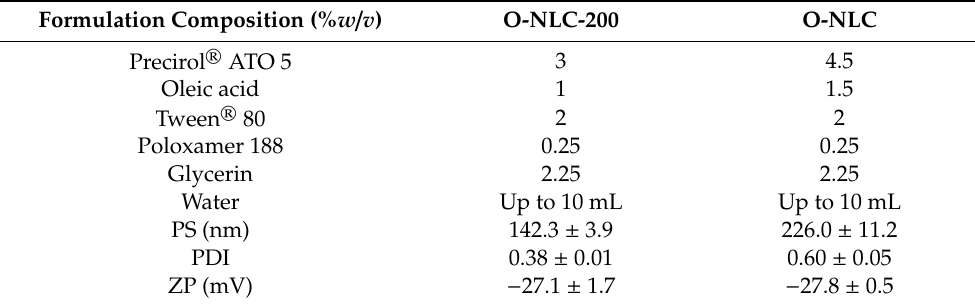
Table 4. E ff ect of lipids to surfactant ratio on particle size, polydispersity index and zeta potential of NLC placebos (mean ± SD, n =